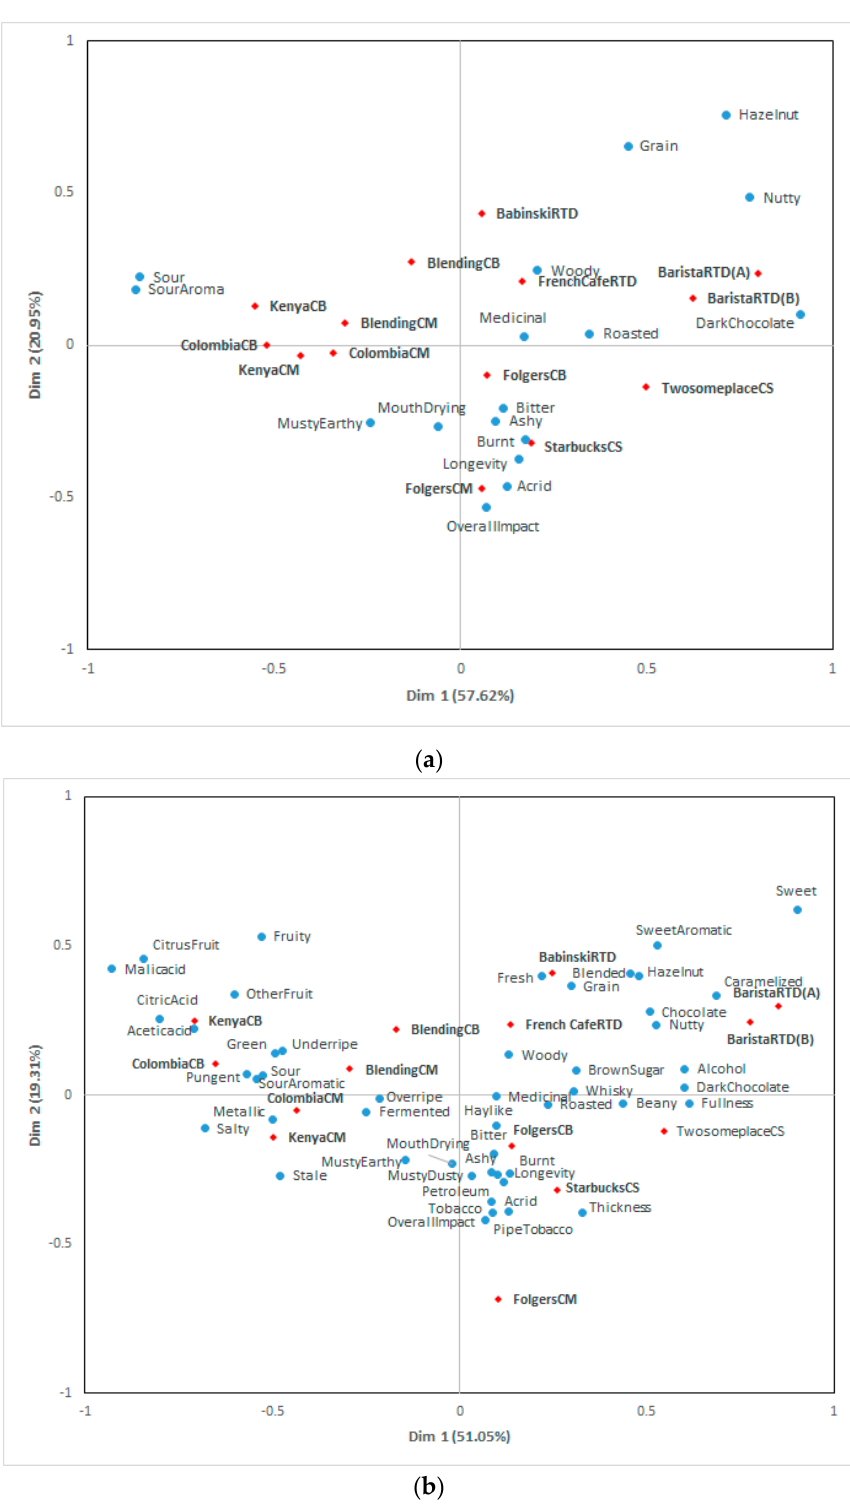
Figure 2. Correspondence analysis bi-plot using 17 commonly selected terms for all cold brew coffee samples by at least 10% of consumers ( a ) and correspondence analysis bi-plot using 48 terms selected for one or more cold brew coffee samples by at least 10% of consumers ( b ).